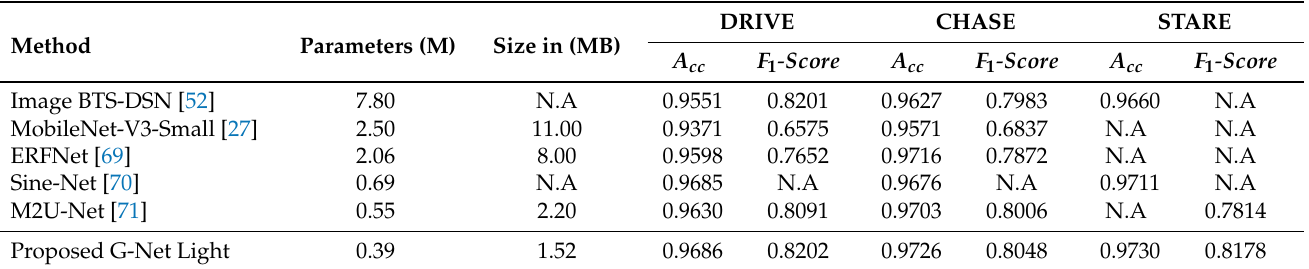
Table 5. Comparison with recent light-weight networks in terms of accuracy and F 1 - score on DRIVE, CHASE and STARE datasets. Best results are highlighted in bold font. The measures that are not available are represented by N.A.